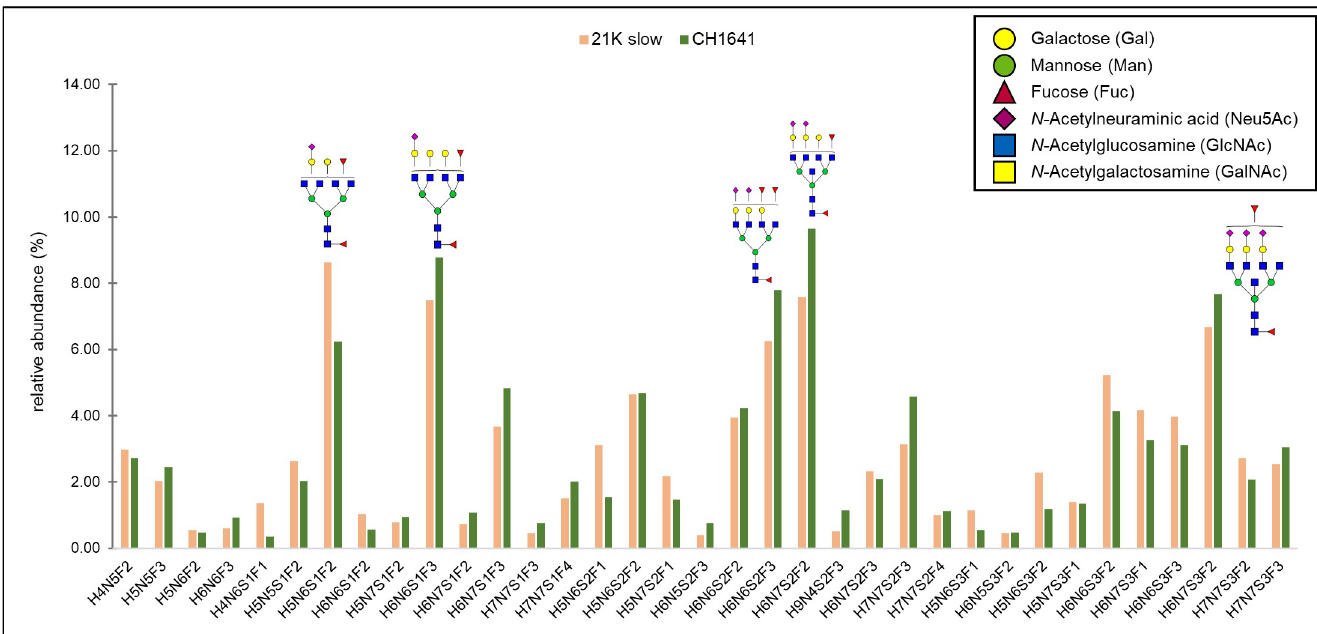
Fig 9. Relative abundances of N-glycans on N-200 peptide. In total, 35 structures are compared between the two strains analyzed. Structures with relative abundance above 5% are represented in the graph. Monosaccharide symbols marked in legend.